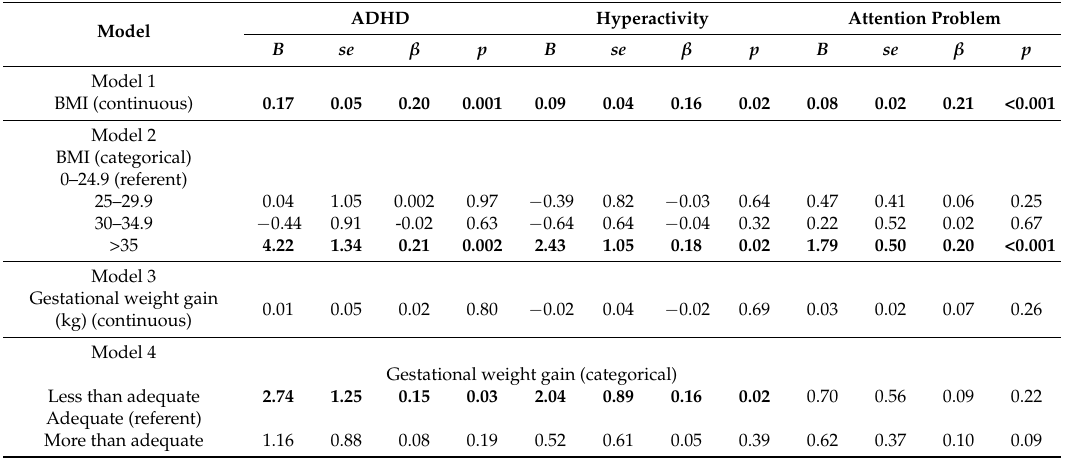
Table 2. Association between pre-pregnancy BMI, gestational weight gain, and childhood BASC ADHD ( n = 331).